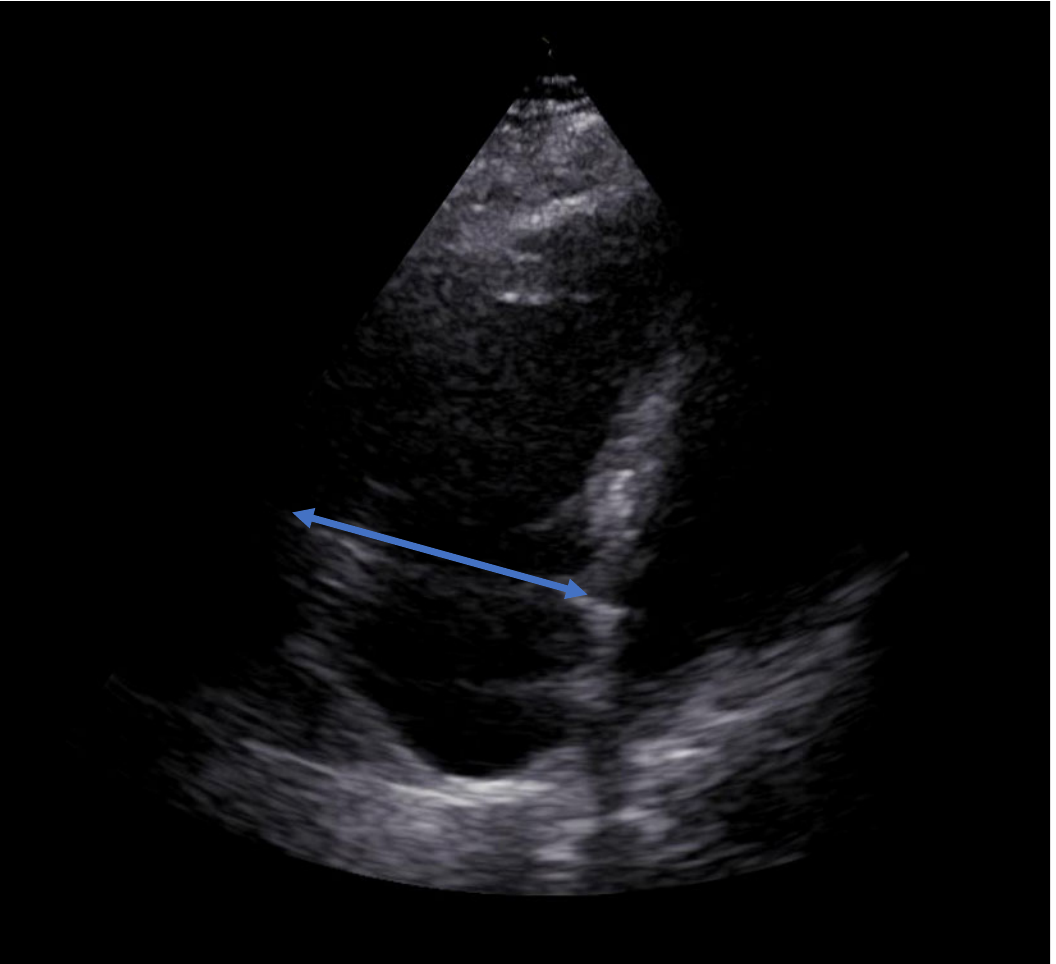
Figure 2. Baseline transthoracic echocardiogram showing a distended right ventricle with a right ventricular end-diastolic diameter (RVEDD) of 6.49 cm (arrow).